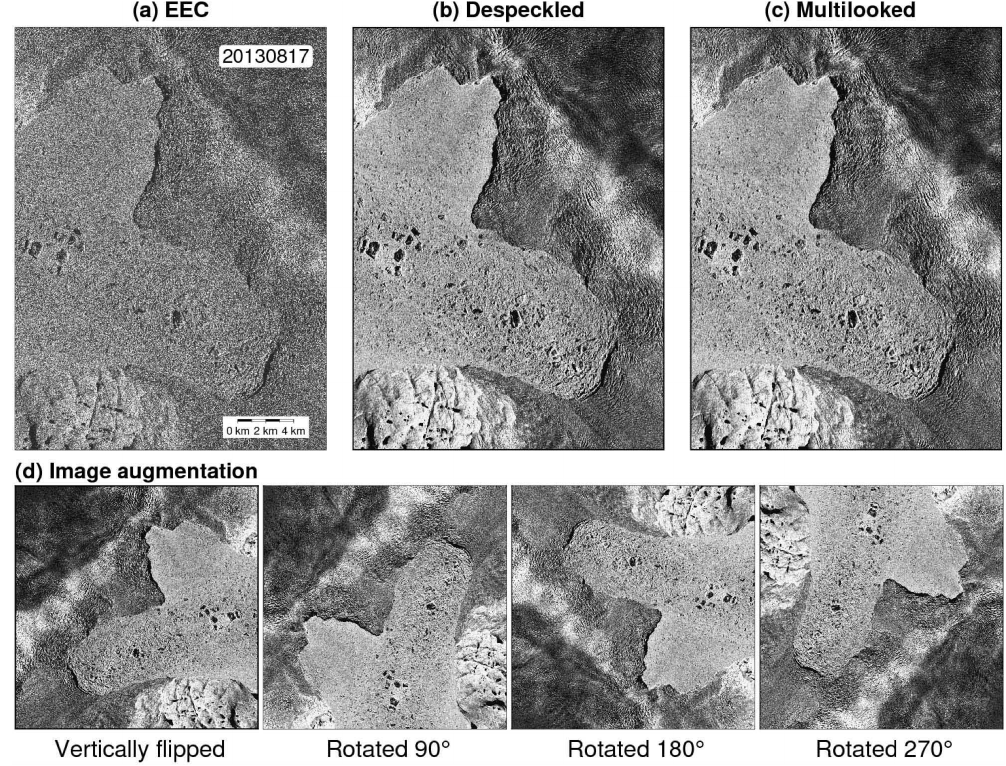
Figure 2. A set of examples of TerraSAR-X data preprocessing and preparation, including the (a) enhanced-ellipsoid-corrected (EEC) product, (b) despeckled image after reducing the speckle noise, (c) multilooked image after decreasing the image size, and (d) images after vertically flipping and rotating (c) by 90, 180, and 270 ◦ , respectively. For ease of presentation, the images in (d) are not to scale with (a) – (c)